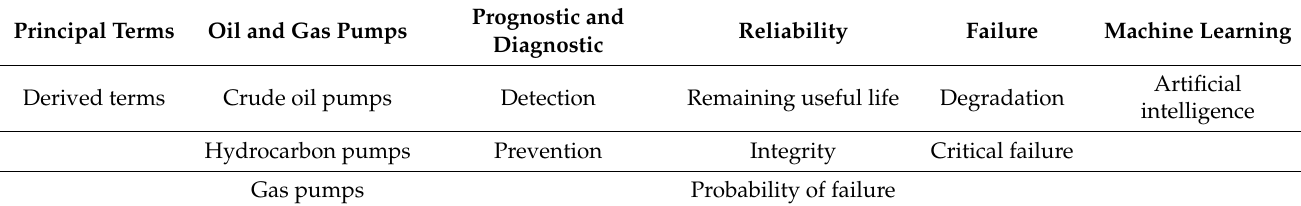
Table 4. Search strategy keywords.